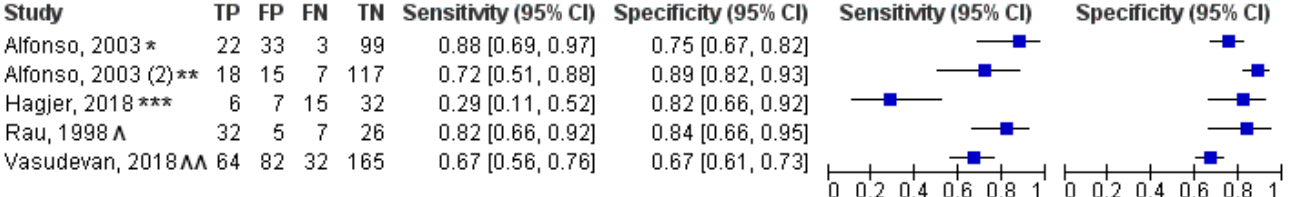
Figure 2. Forest plot of C-reactive protein delineating the sensitivity and specificity of the test. Alfonso, 2003 *(> 200 mg/L); Alfonso, 2003 (2) **(> 279 mg/L); Hagjer, 2018 ***(150 mg/L); Rau, 1998 ^(> 140 mg/L); ^^